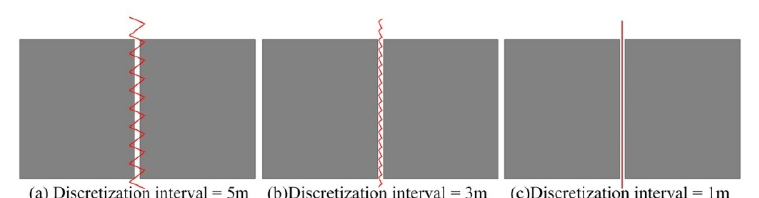
Figure 8. Illustration of the effect of the discretization interval causing “saw-like” geometry on the boundary between adjacent buildings ( a ) compared to the ideal combination ( b , c ).